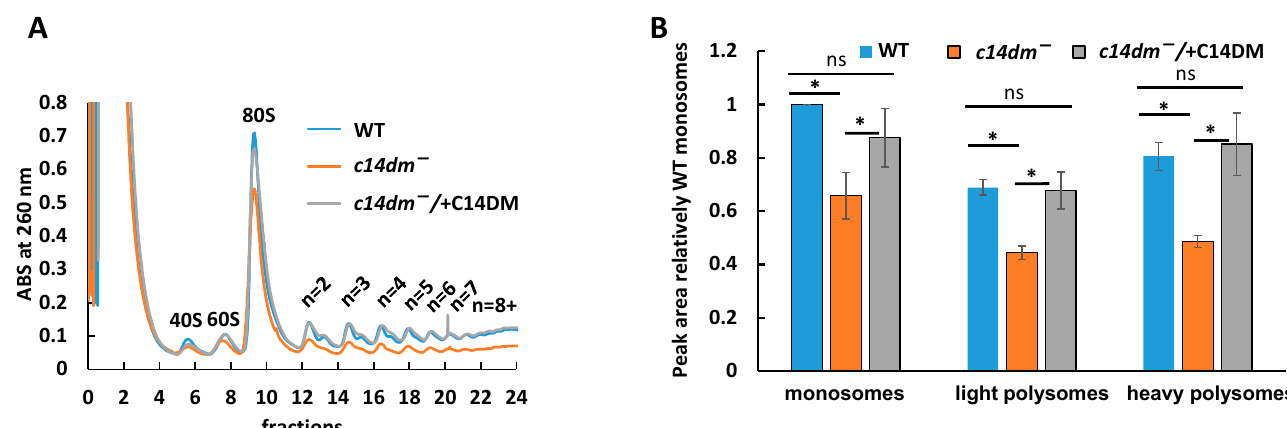
Figure 7. C14dm ̅ mutant displays reduced monosomal and polysomal peaks. ( A ) Polysomal profile of WT (blue), c14dm ̅ (orange) and c14dm ̅ / + C14DM (grey). Ribosomal subunits and polysomes are indicated based on absorbance at 260 nm. The experiment was conducted in four biological repeats, and one representative profile is shown here. ( B ) Quantification of the results shown in ( A ). Areas for peaks of monosomal fractions (80S), the light polysomes ( n = 2-4) and heavy polysomes ( n = 5-8+) were calculated using trapezoidal sum (https://bit.ly/36YJVo1 (accessed on 12/07/2020)). Peak areas were then normalized to the WT monosomes. ns: not significant; *: p < 0.05.